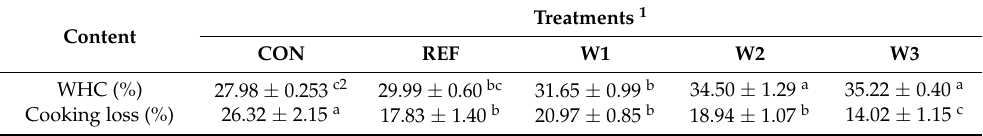
Table 5. Water-holding capacity (WHC) and cooking loss of Tteokgalbi supplemented with different W